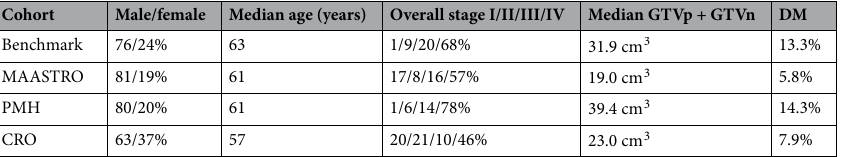
Table 3. Comparison of clinical variables and percentage of patients having a DM among the different cohorts used in this